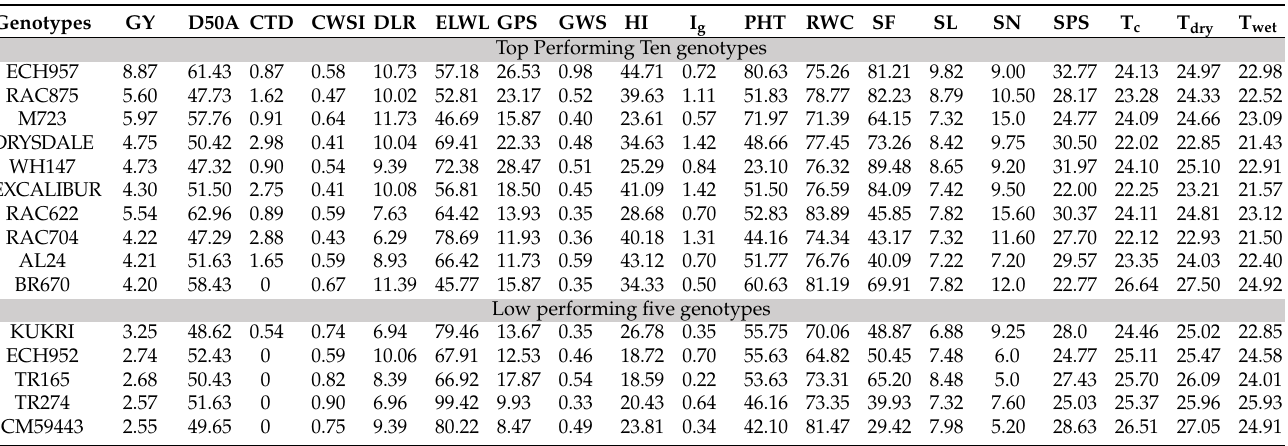
Table 4. Adjusted mean values of the ten best-performing and five low-performing genotypes under drought stress. Genotypes are ranked based on enlisted traits in the